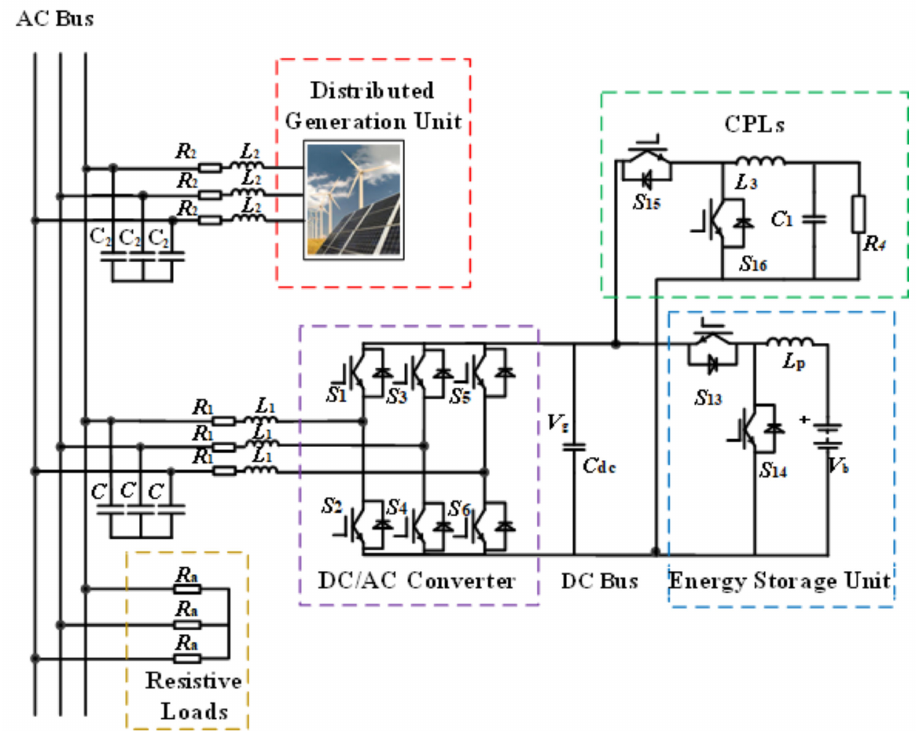
Figure 1. AC/DC Hybrid Microgrid